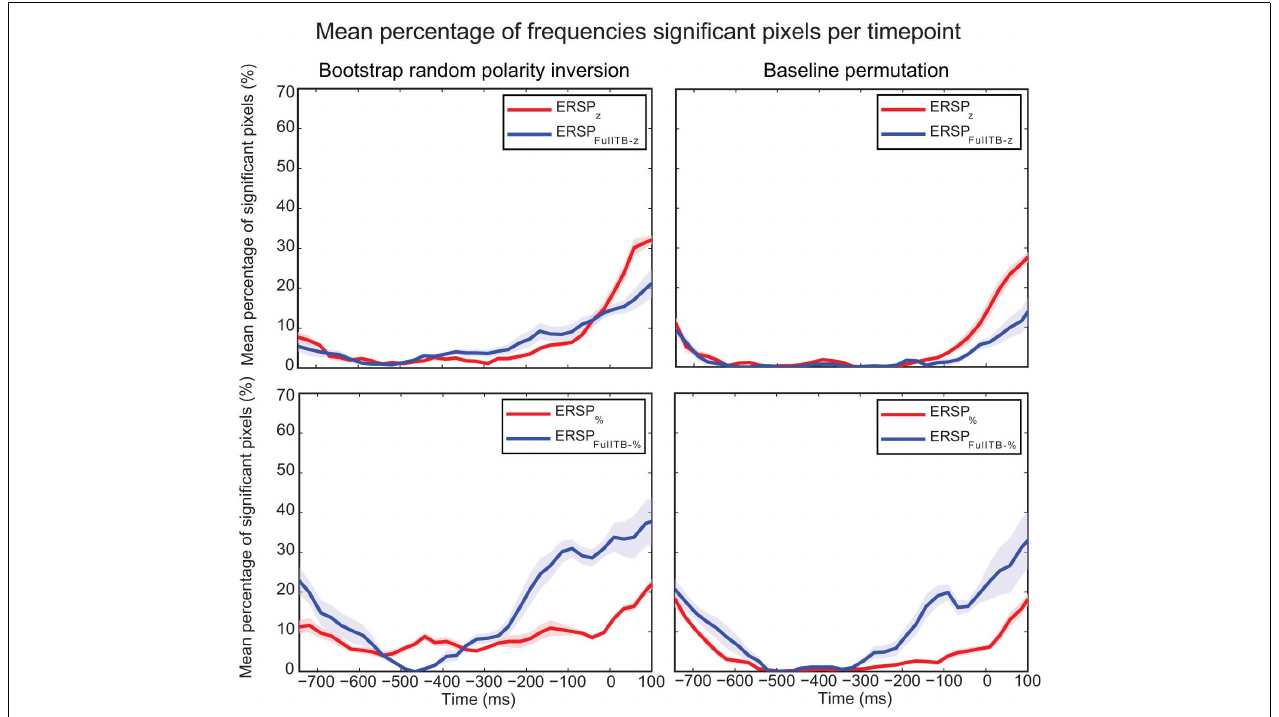
shown on the right column.Two different ERSP methods are compared: ERSP z displayed in the upper row, and ERSP % displayed in the lower row. Classical baseline correction methods are represented in red and single-trial correction methods are represented in blue. Shaded areas represent SE of the